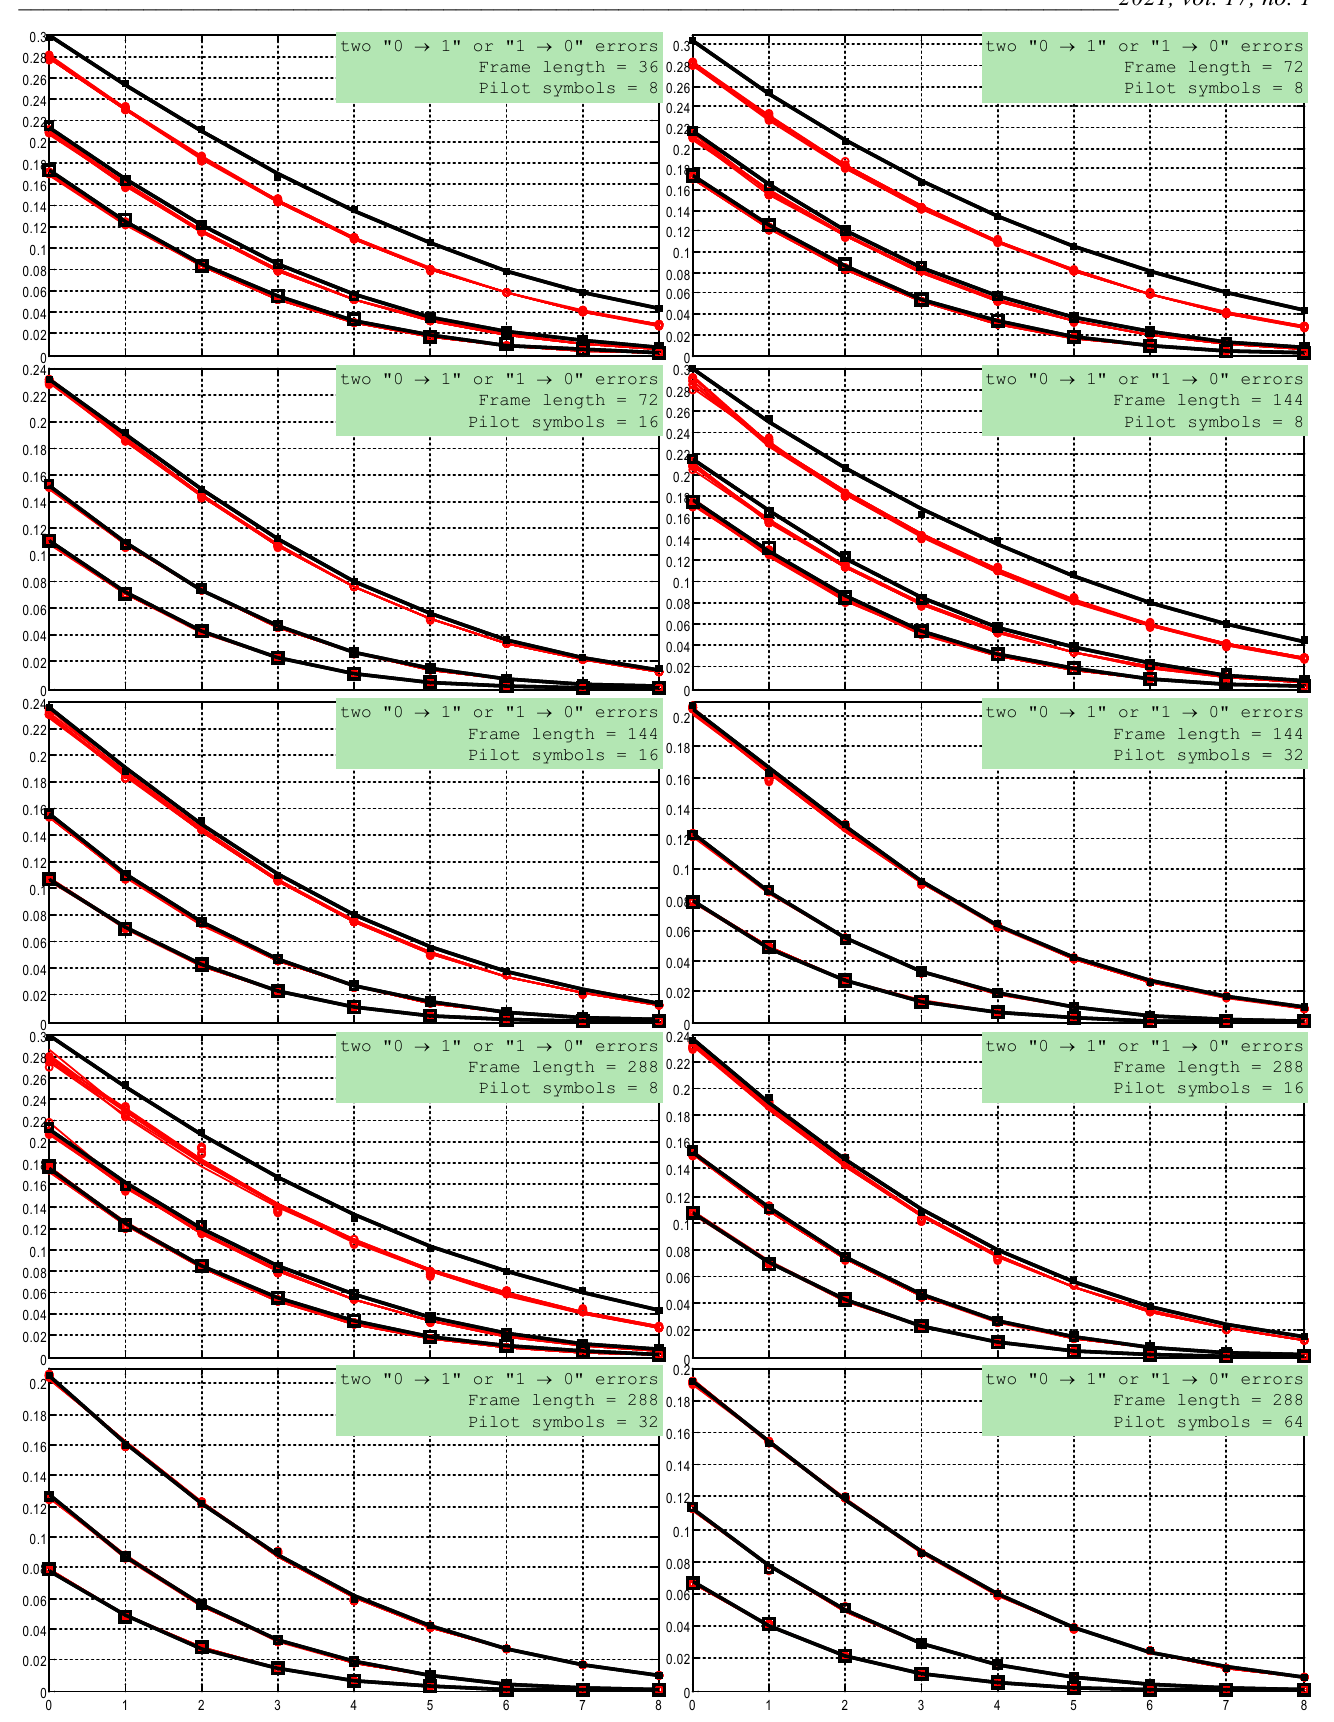
Fig. 8. The BER performance versus BENDR in the case of two repeated indefinite pilot sequence symbol errors (see Table II, PSdeO by simulation case